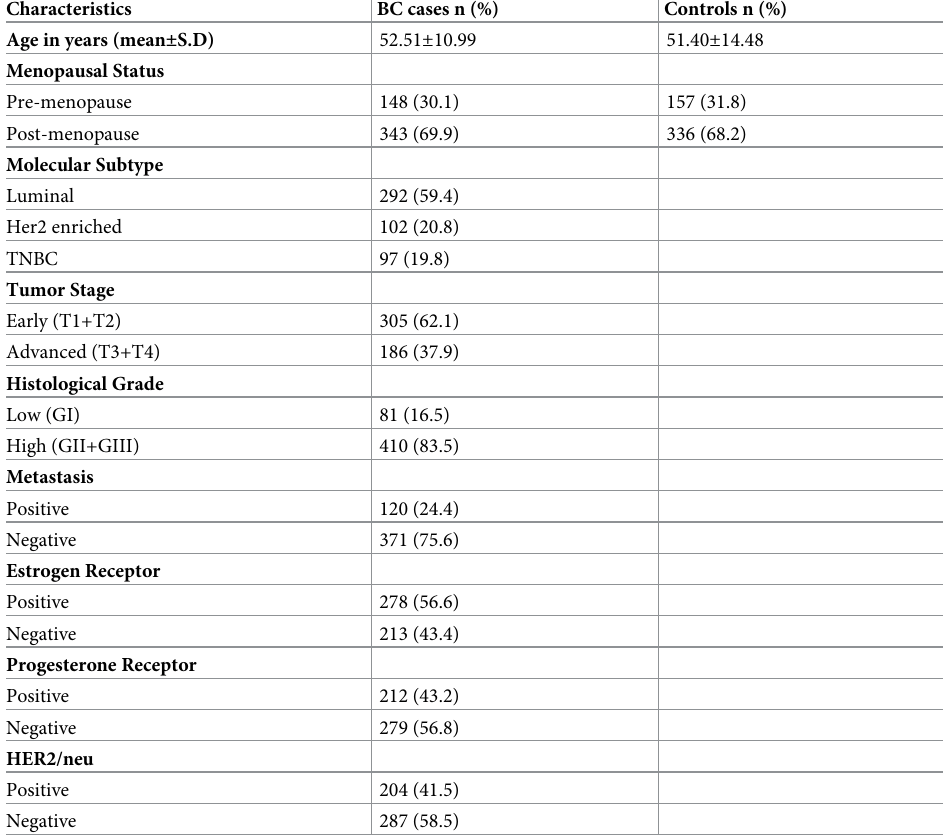
Table 2. Demographic and clinicopathological characteristics of the study subjects.